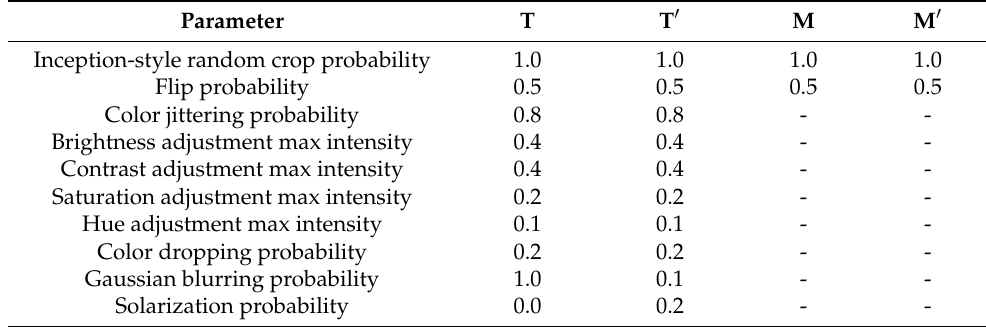
Table A1. Parameters used to generate image